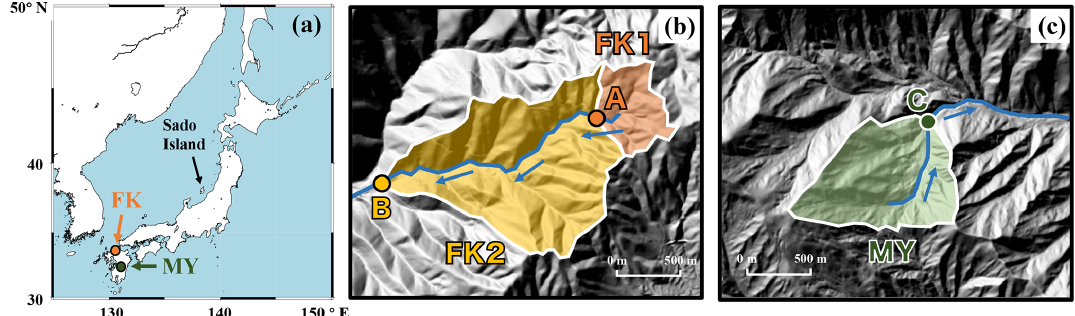
Figure 1. A map showing the locations of the study catchments (FK and MY) in Japan (a) , and the maps of FK1, FK2 (b) , and MY catchments (c) , shown by orange, yellow, and green areas, respectively, together with the sampling station A, B, and C, respectively, shown by orange, yellow, and green circles, respectively. The blue arrows indicate the flow direction of stream water.